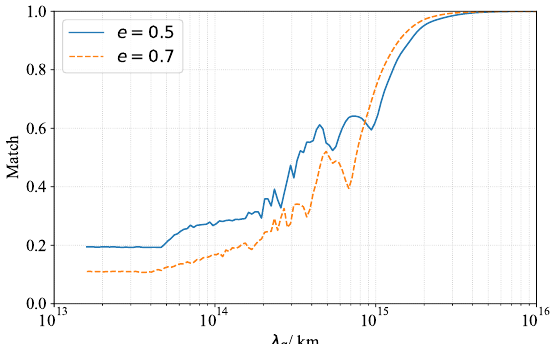
Figure 3. Matches between dispersive and nondispersive GW series in different e and λ The curves begins at λ g = 1.6 × 10 13 km, the total masses of systems are M = 10 6 M (cid:12) , where the symmetric mass ratio ν = 10 − 5 , e = 0.5 (cyan line) and e = 0.7 (orange line), p = 12 M , and a = 0.9. For the GW series, the duration is 2 25 s (~1.06 year) and the sampling frequency is 0.25 Hz. We set D L = 1.00 Gpc, where Z ≈ 0.20 and D ≈ 0.83 Gpc.